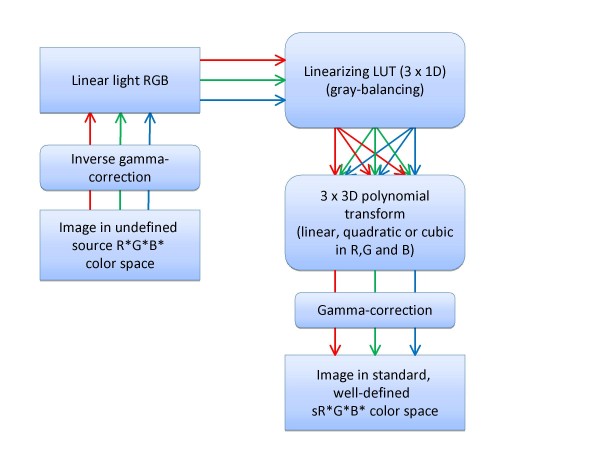
RGB to sRGB Transformation Scheme.